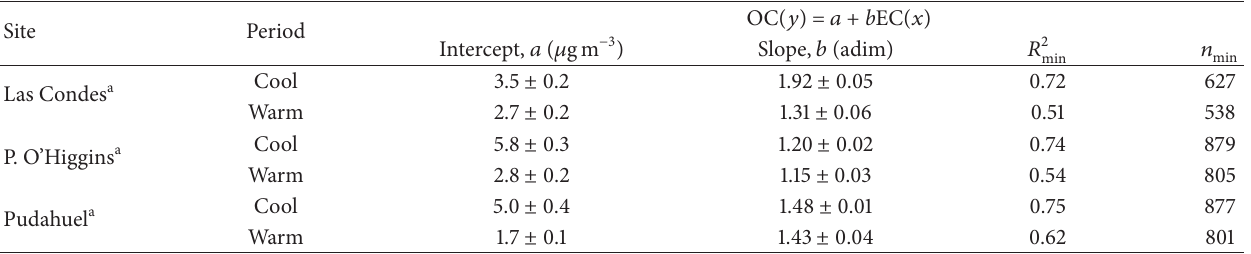
Table 5: OC versus EC minimum linear correlation in PM 2.5 for the stations studied in the period from 2002 to 2007. 𝑎 is the slope, 𝑏 (adim) is the intercept ( 𝜇 g/m 3 ), 𝑅 2 is the square of the correlation coefficient, and 𝑛 is the number of data pairs.